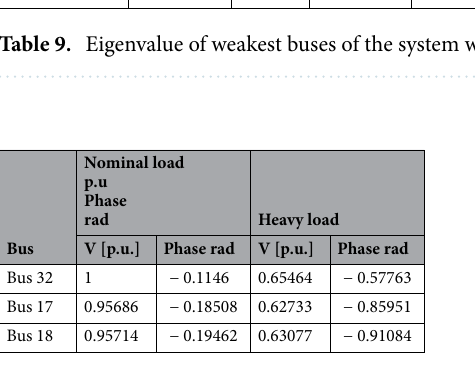
Table 10. Power flow results of the system with SPVG PV-model and